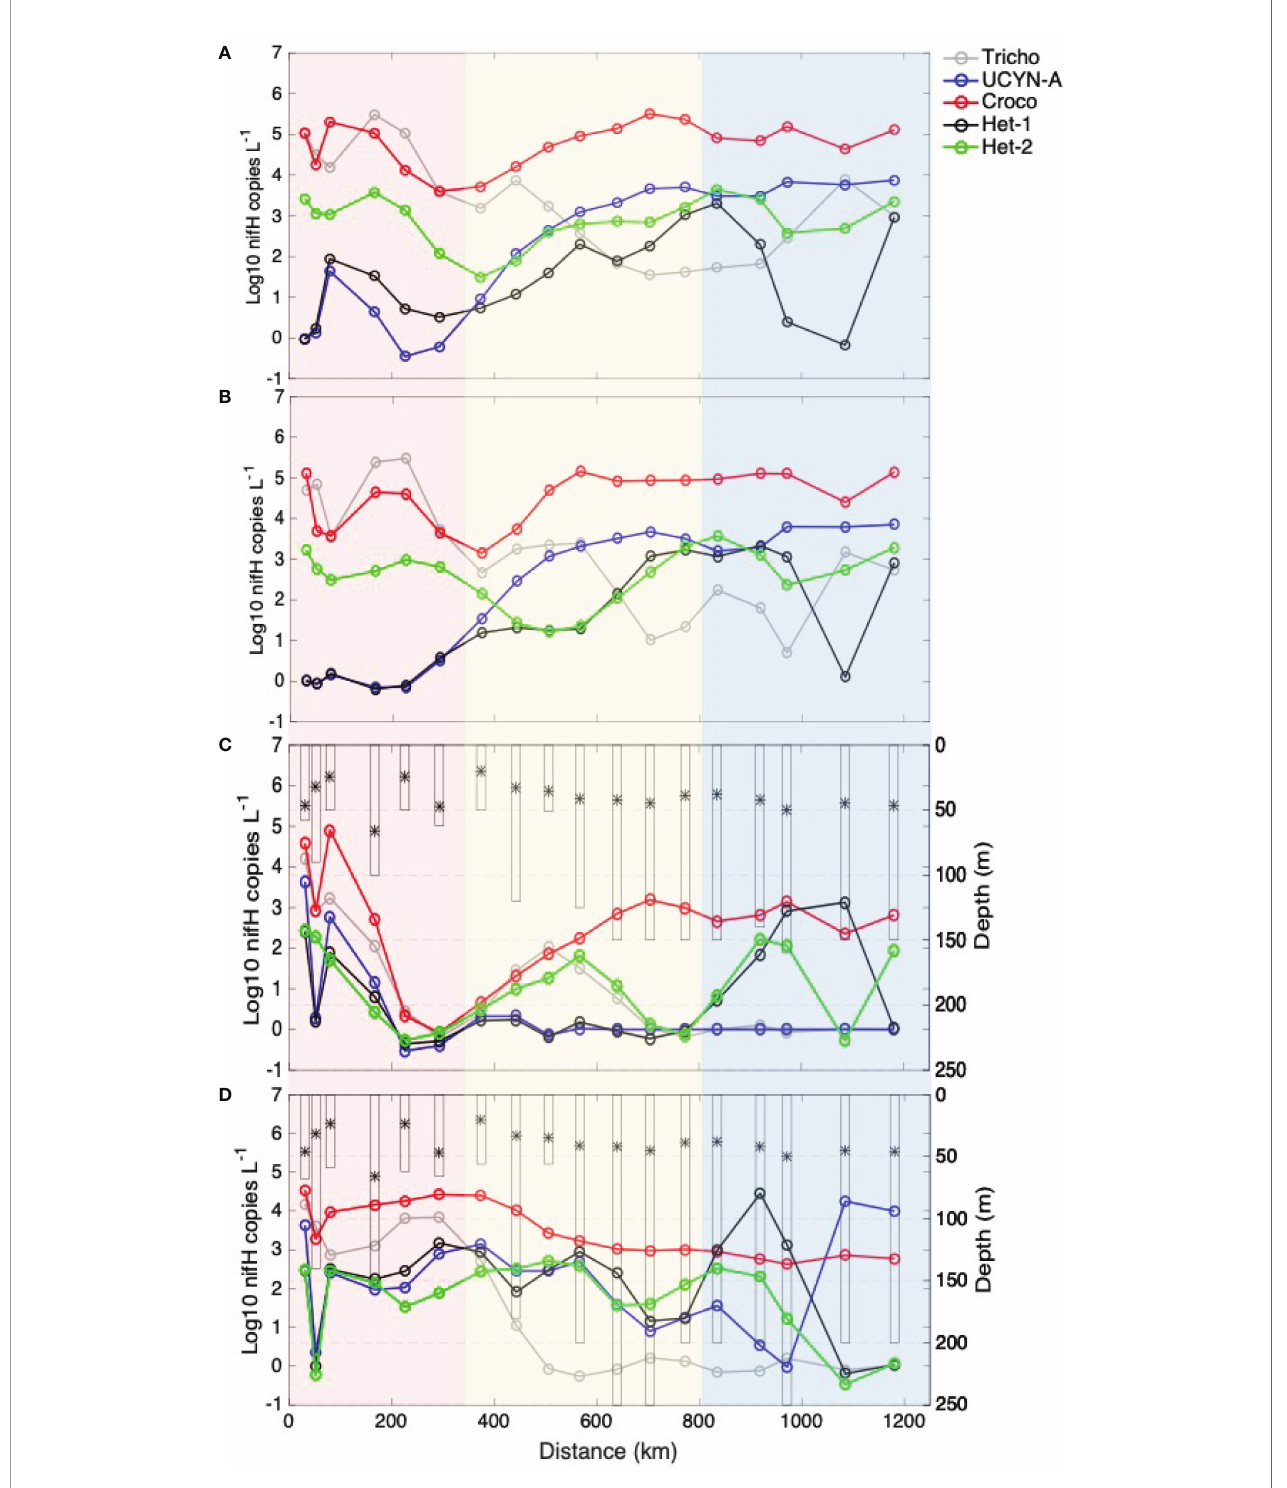
FIGURE 3 | Spatial distribution of nifH gene copies for each nitrogen- fi xing phylotype [log10 (copies L -1 )]: Trichodesmium (Tricho) (grey), UCYN-A (blue), Crocosphaera (Croco) (red), Het-1 (black), and Het-2 (green), along the sampled transect through the three sectors: West (shaded in pink), Middle (shaded in yellow), and East (shaded in blue) derived from a hierarchical cluster analysis of the physical parameters. Data from each sample depth are plotted as follows: (A) surface, (B) 10 m, (C) DCM, where the DCM depths for each station are shown with bars (D) bDCM, where the bDCM depths for each station are shown with bars. The asterisk (*) denotes the mixed layer